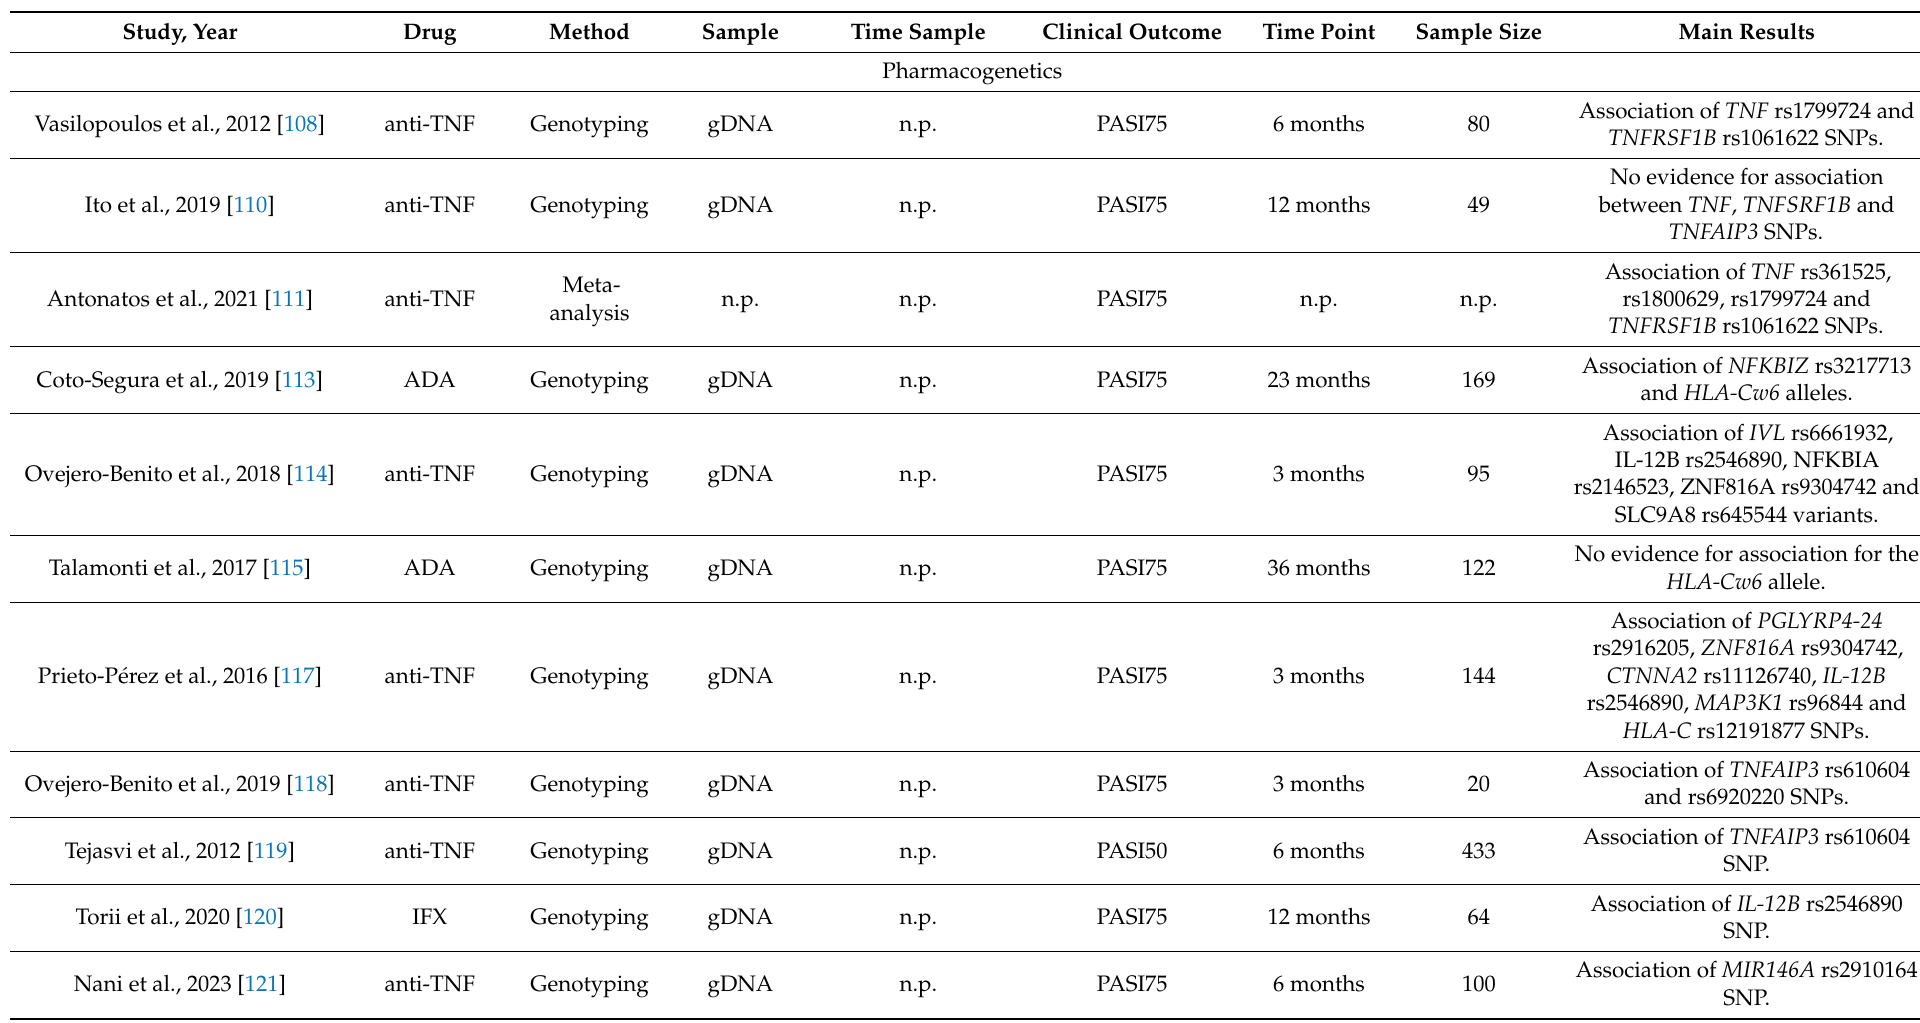
Table 3. Pharmaco-omic approaches applied in anti-TNF